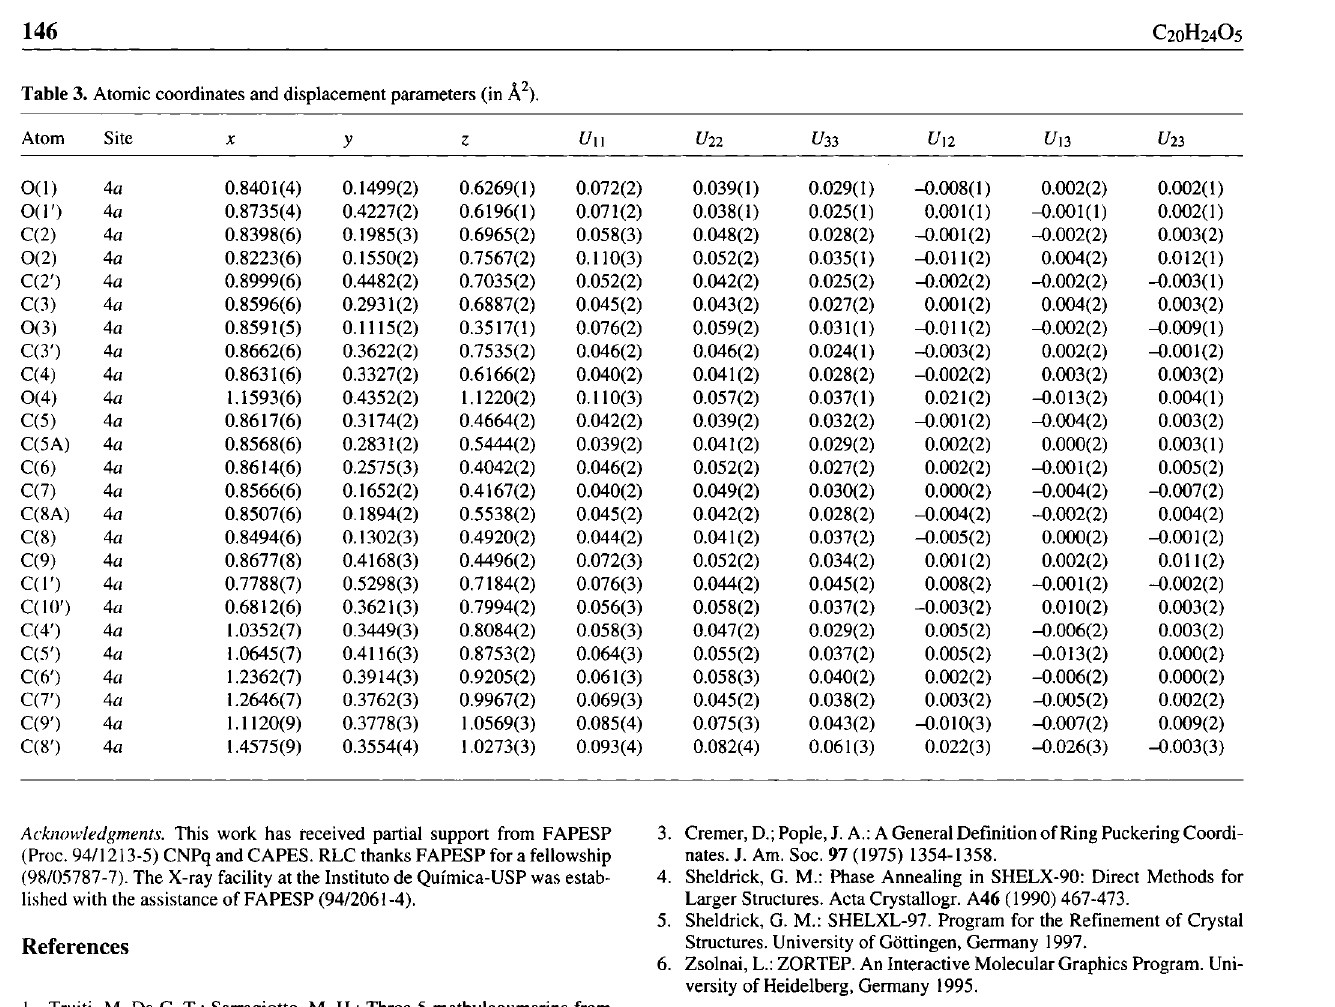
Table 3. Atomic coordinates and displacement parameters (in Ä 2